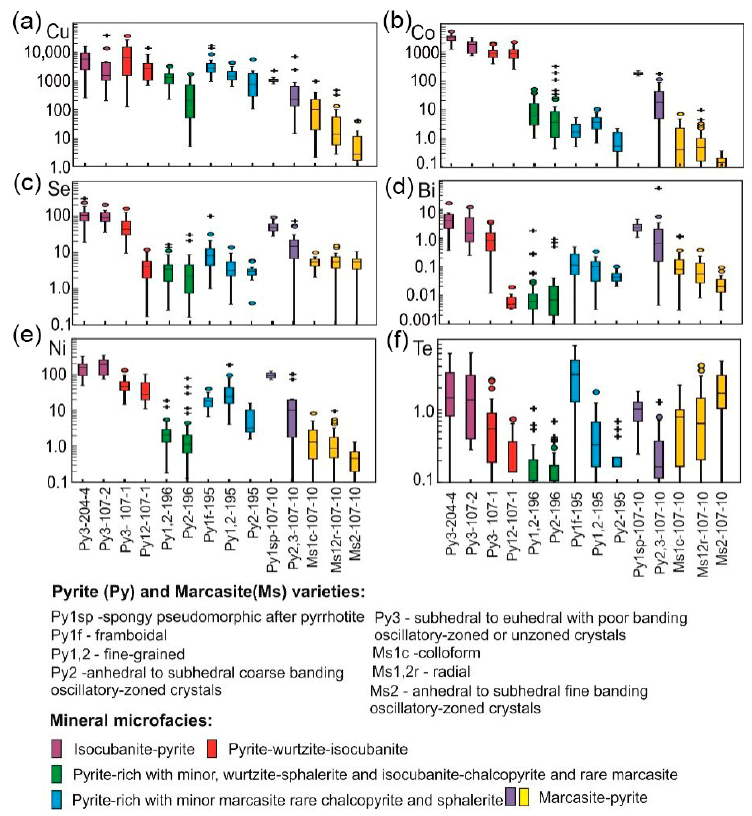
Figure 10. Whisker-and-box plots for the high-temperature association of elements Cu (a) , Co (b) , Se (c) , Bi (d) , Ni (e) , and Te (f) in pyrite and marcasite ranged in isocubanite-rich, pyrite-, and marcasite-pyrite-rich microfacies. The box encloses the interquartile range with median displayed as a line. The vertical lines extending outside of the box mark the minimum and maximum element concentrations encountered. Outliers are plotted as single points.